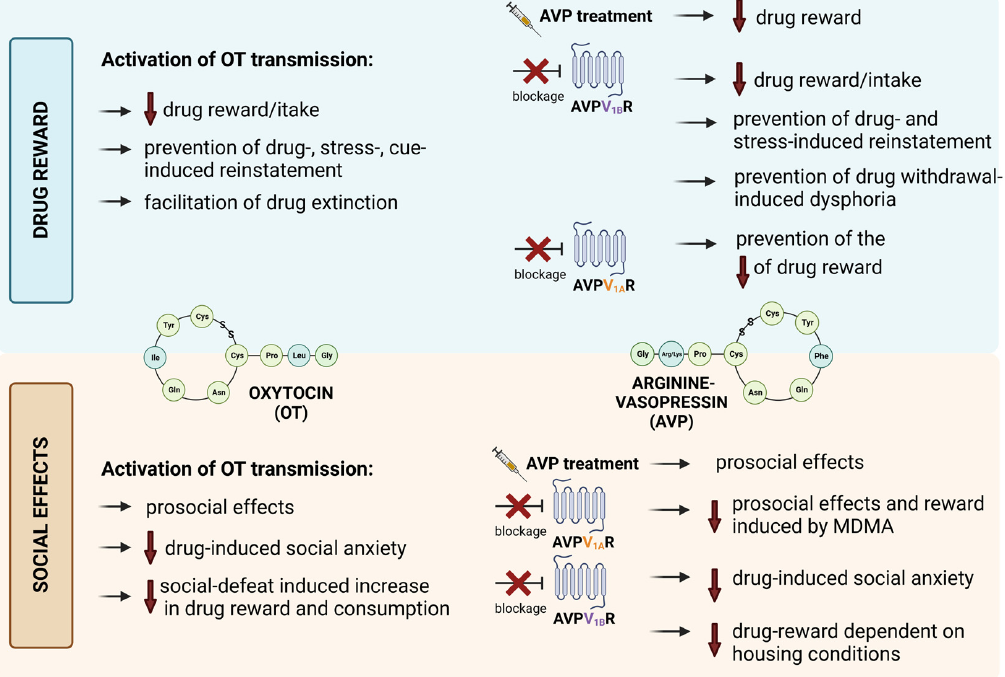
Figure 3. The summary of available data on OT/AVP effects on drug reward and social effects. Detailed descriptions are presented in Sections 3.1–3.3. This figure was created with https://biorender.com/ (accessed 10 January 2023 ) .